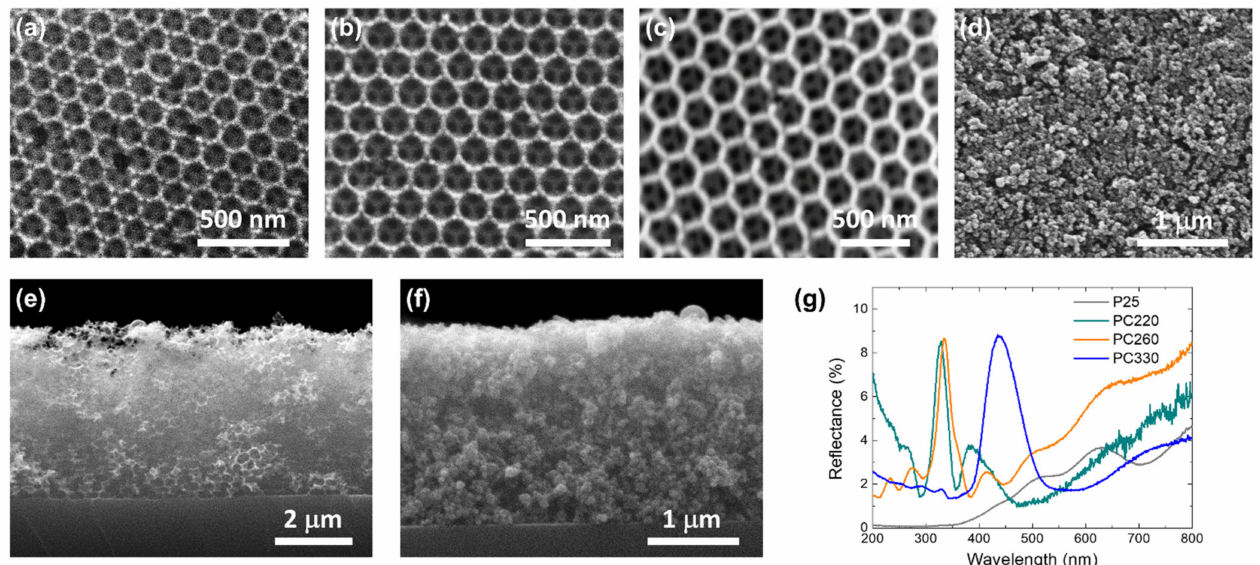
Figure 1. Top-view SEM images of ( a ) PC220, ( b ) PC260, ( c ) PC330 TiO 2 inverse opals in comparison with the ( d ) mesoporous P25 films. Cross-sections of ( e ) PC260 and ( f ) P25 films. ( g ) Specular reflectance (R%) of the PC and P25 films at 15 ◦ incidence